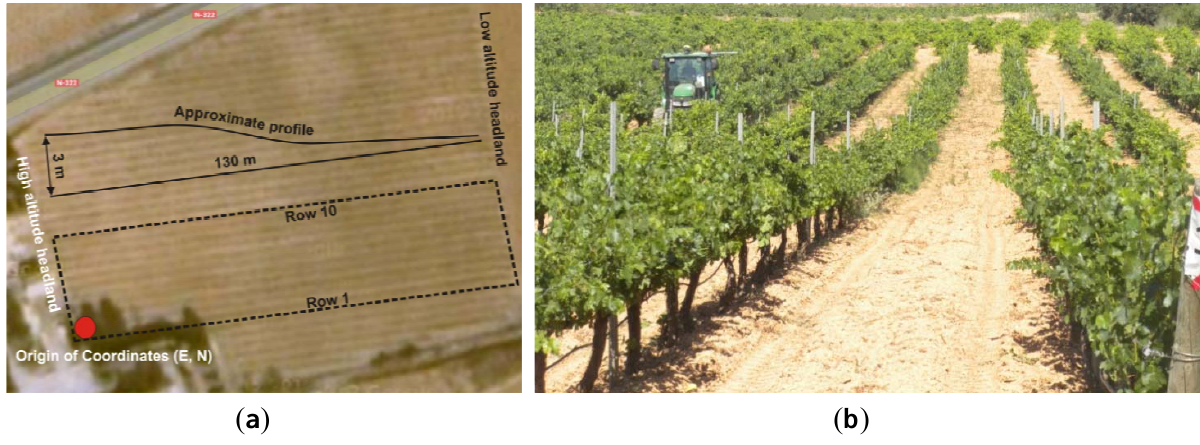
Figure 2. ( a ) Top view of experimental field: row selection; ( b ) Vine status at testing period between véraison and grape